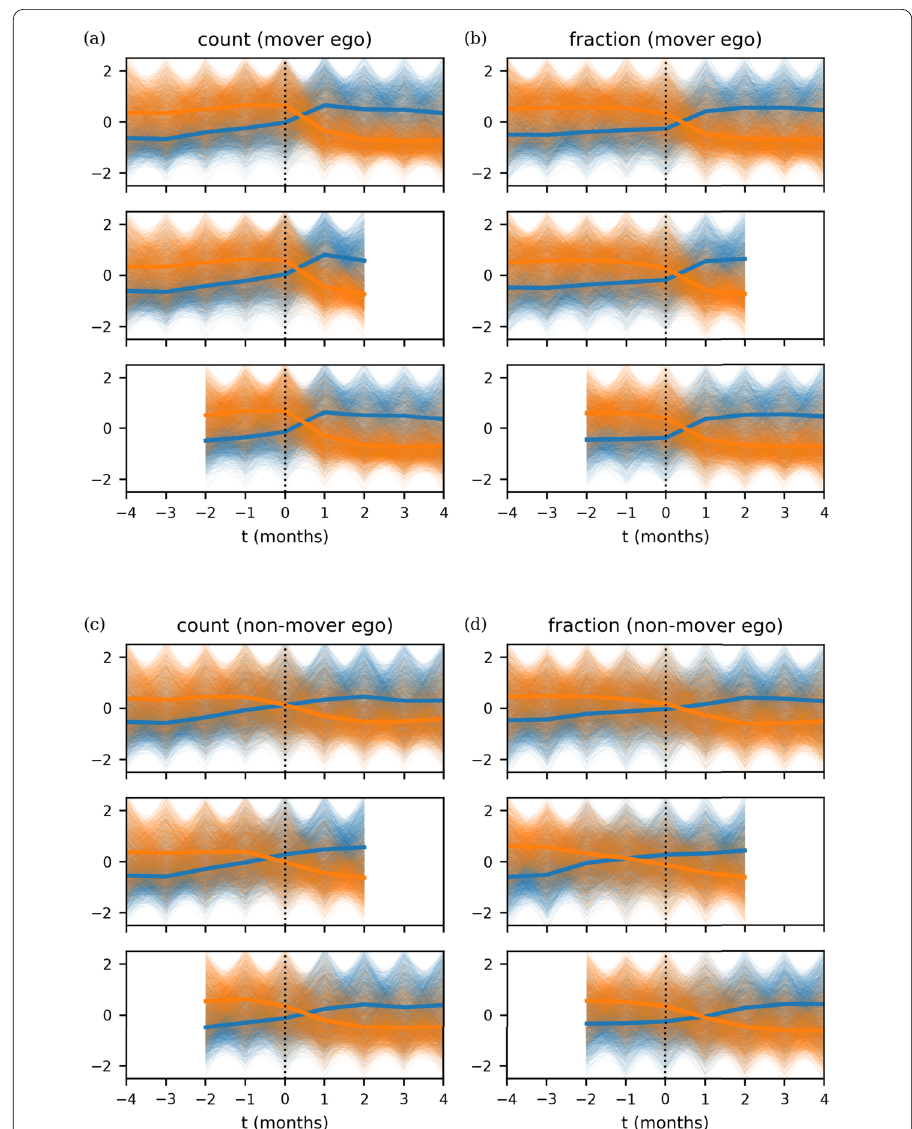
Figure 3 Clusters found in the original vs. control datasets. These plots show the clustering results on the standardised time series. Note that the rise or decay happens in various locations for the control dataset where the ego is a non-mover assigned a dummy moving month (( c ) and ( d )) but remains fixed (between t = 0 and t = 1) for the original dataset where the ego is a mover (( a ) and ( b )). A dotted line at t = 0 is included for guiding the